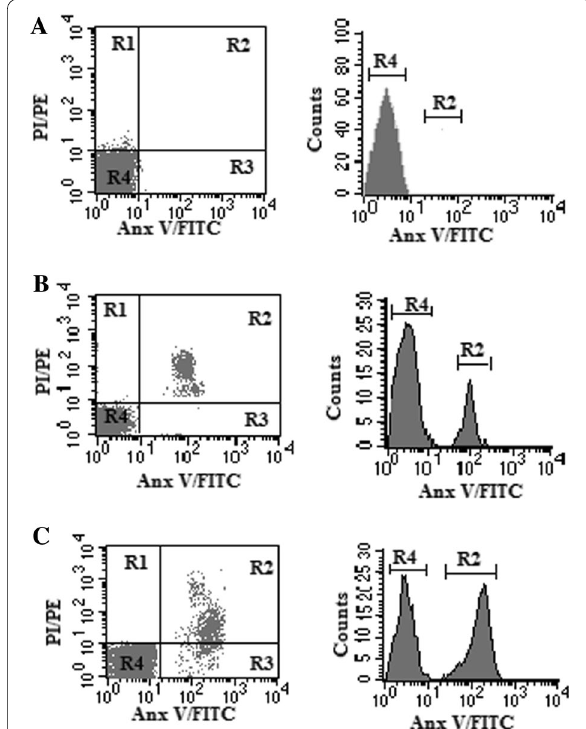
Fig. 1 Flow cytometry assessment of apoptotic cells. A Control, B acute myeloid leukemia , C acute lymphoblastic leukemia ). Annexin V FITC (AnxV FITC) and propidium iodide PE (PI PE) fluorescence. Regions: R4 normal cells, R2 late apoptotic (AnxV apoptotic (AnxV +